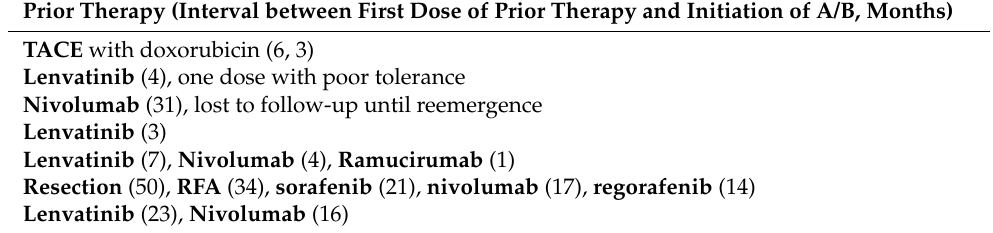
Table 2. Timing and use of prior therapies targeting HCC in the seven patients with prior treatment.